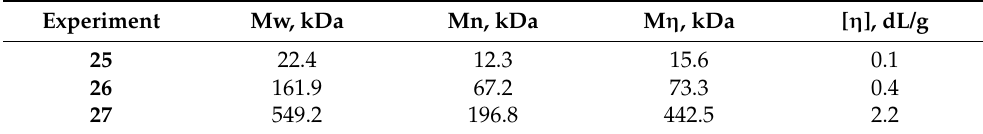
Figure 14. Reduced viscosity vs. concentration for dilute solutions of polymers 25 – 27 in toluene (T = 37 °C). Table 6. Molecular weight characteristics of polymers 25 – 27 . Table 6. Molecular weight characteristics of polymers 25 – 27